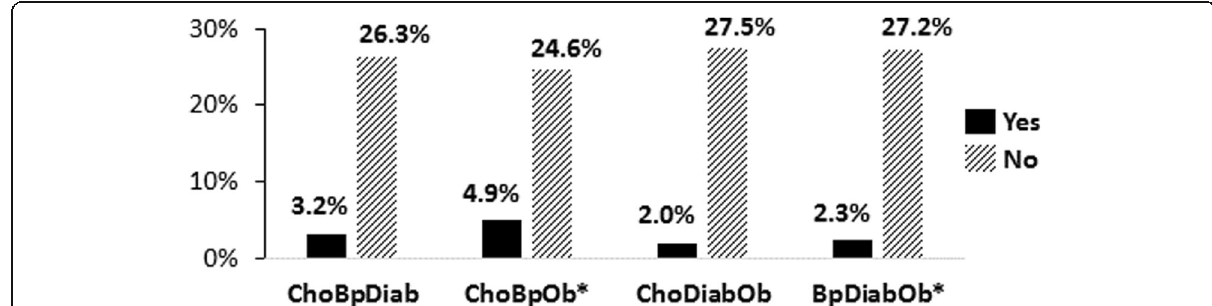
Fig. 3 CAM Use by Disease Triads. [Yes = Used CAM and had the disease triad; No = Used CAM but did not have the disease triad]; Disease Triads: ChoBpDiab = Hypercholesterolemia and Hypertension and Diabetes; ChoBpOb = Hypercholesterolemia and Hypertension and Obesity; ChoDiabOb = Hypercholesterolemia and Diabetes and Obesity; BpDiabOb = Hypertension and Diabetes and Obesity; Significance levels: * p < 0.05 , ** p < 0.01 , *** p <